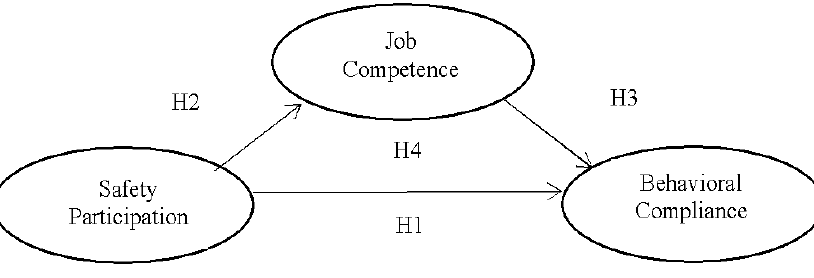
Figure 1. Theoretical model.